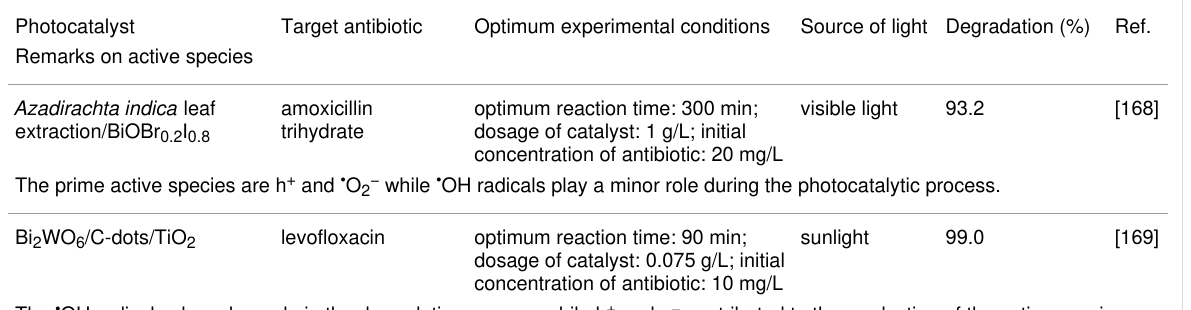
Table 8: Bi-based nanocomposite/heterojunction photocatalysts for antibiotic remediation.